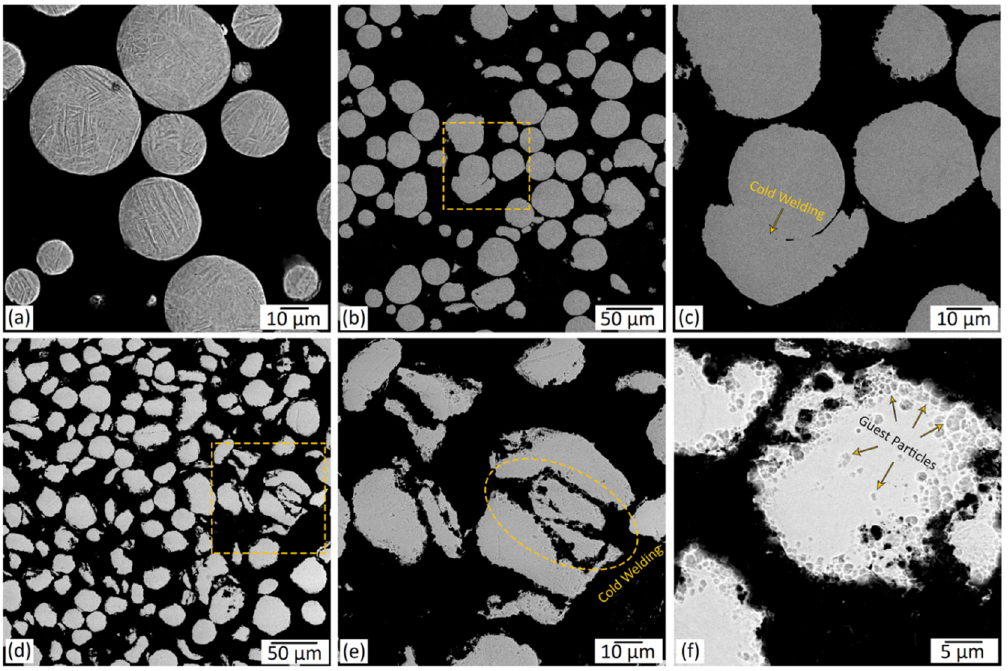
Figure 6. Cross-sectional SEM micrographs of: starting Ti-6Al-4V powder showing a martensitic Figure 6. Cross ‐ sectional SEM micrographs of: starting Ti ‐ 6Al ‐ 4V powder showing a martensitic